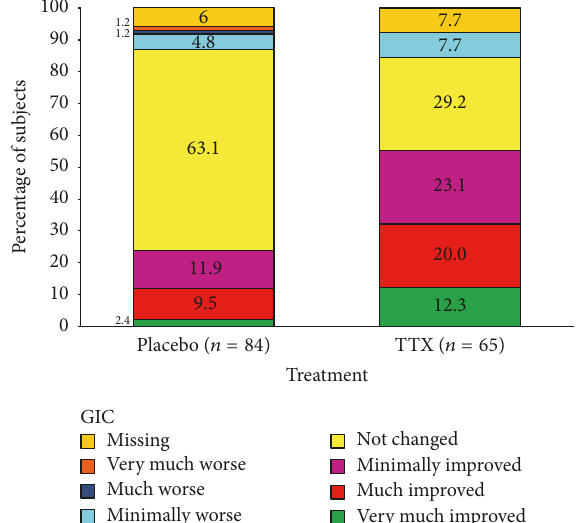
Figure 3: TTX for cancer pain: secondary analyses. Patient global impression of change (GIC) during the late postinjection